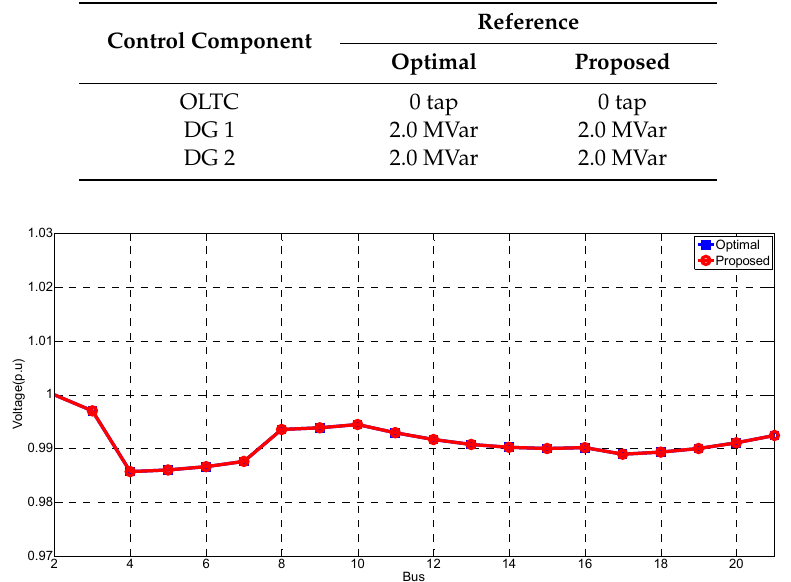
Table 5. Simulation results of the tap position and reactive power for nominal voltage in case 2.